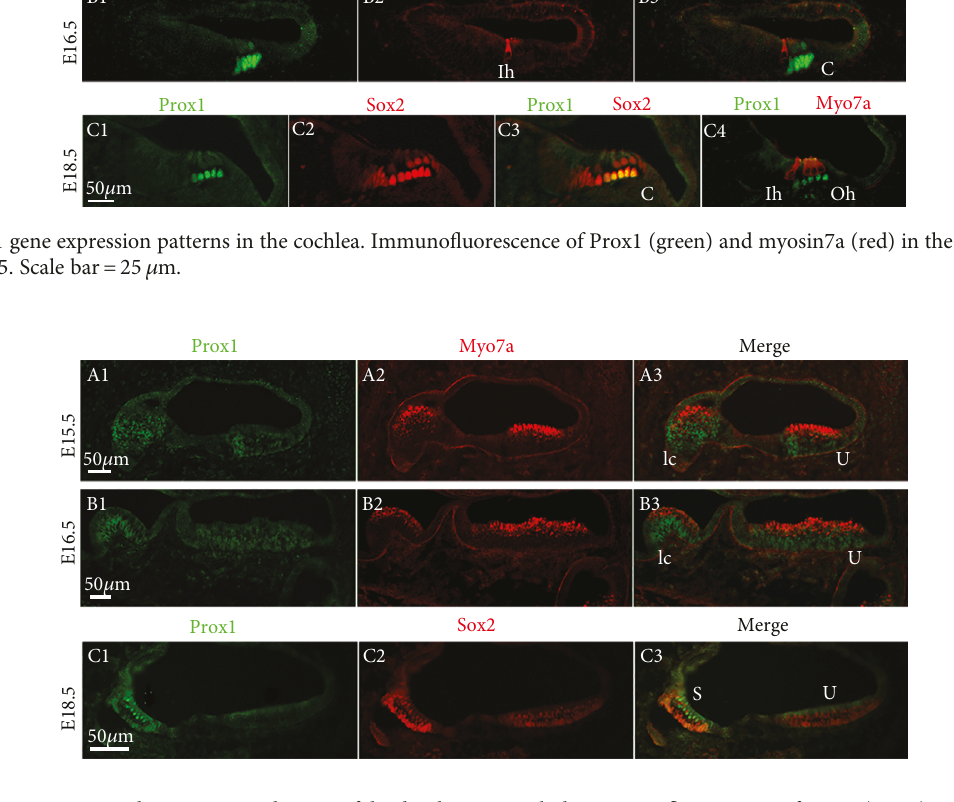
Figure 5: Prox1 expression in the prosensory domain of the developing vestibule. Immuno fl uorescence of Prox1 (green) and myosin7a/Sox2 (red) in the macula sacculi, macula utriculi, and crista ampullaris from E13.5 to E18.5. S: saccule; U: utricle; pc: posterior crista; lc: lateral crista. Scale bars =50 μ m.